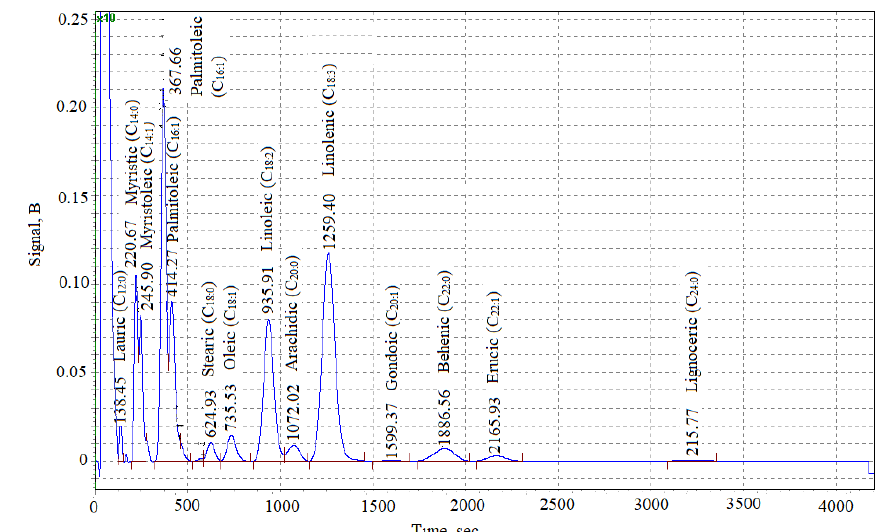
Fig. 4. Gas chromatogram of fatty acid composition in a lipophilic fraction of barley stalks (Shedevr variety)